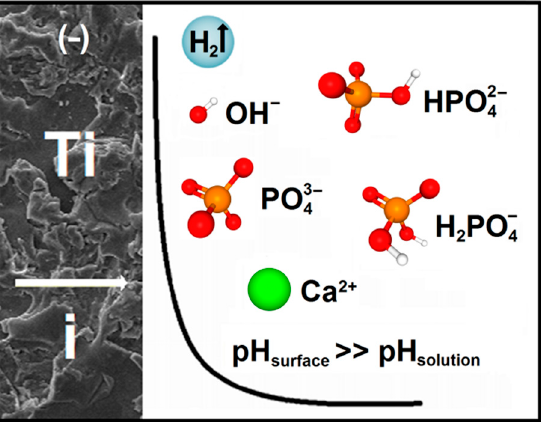
Figure 2. The ECAD mechanism of CaP coatings on the CpTi G4 substrate in the acetate bath.